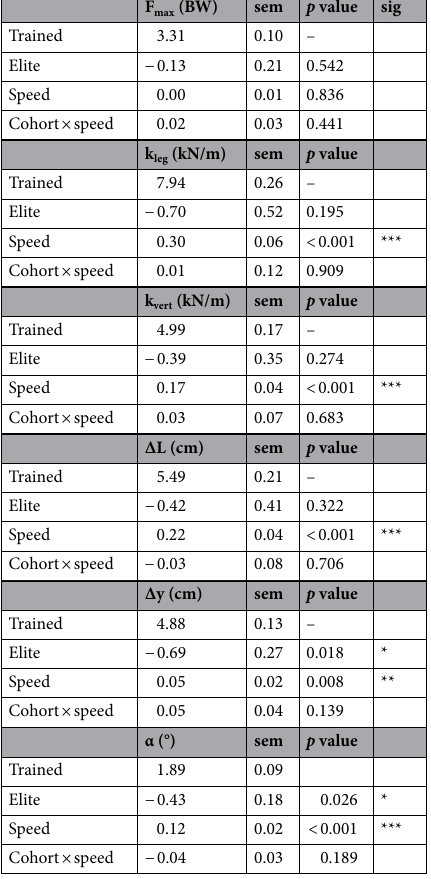
Table 5. Coefficients of variation (expressed as a %) for spring-mass characteristics with effects for cohort, speed, and the interactions. The values provided for the trained cohort correspond to the model estimate at 14 km/h with the elite difference, speed-relation (all subject change per km/h), and cohort-speed interaction presented below that. Estimated standard errors are provided for each effect 68 . Statistical significance of each effect is indicated as: * p < 0.05, ** p < 0.01, and *** p <